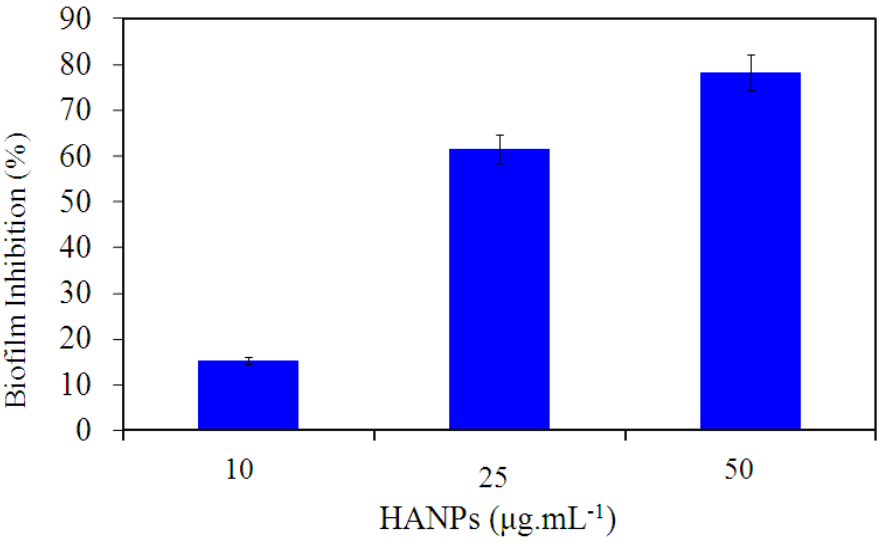
Figure 3. Antibiofilm property of HANPs against P. aeruginosa biofilm ATCC 10145 treated with various concentrations of HANPs for 24 h ( p ≤ 0.05).